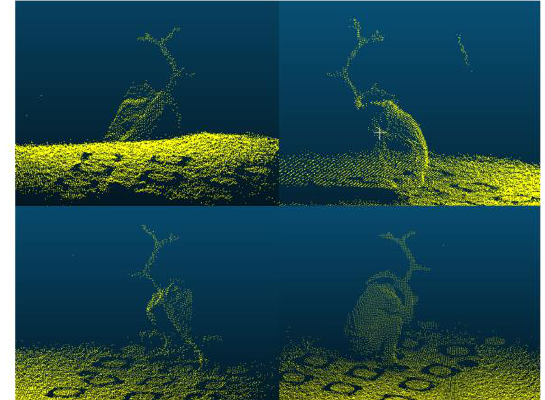
Figure 9. Single frames of the antler point cloud from four ToF cameras.